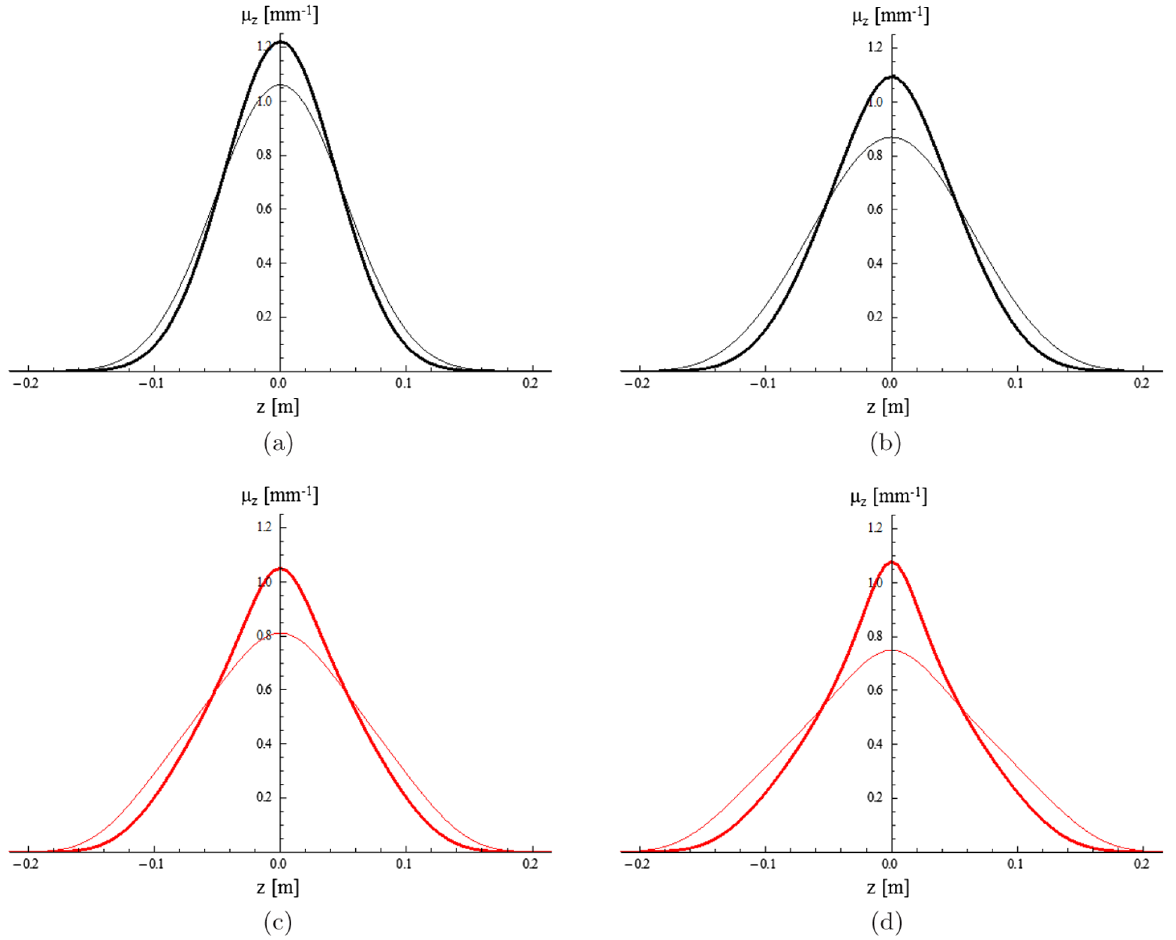
FIG. 4. Line PU density μ z ð z Þ ½ mm − 1 (cid:4) as a function of the longitudinal position z [m] inside the detector. These snapshots are taken at the beginning (thin lines) and in the end (thick lines) of the β (cid:1) leveling process, for different bunch profiles and r.m.s. bunch length σ z . ¼ 135 , which represents the total number of interactions per bunch crossing at the leveled All these distributions are normalized to μ tot luminosity of 5 × 10 34 cm − 2 s − 1 (see Table I). (a) Gaussian bunch profile with σ z ¼ 7 . 5 cm, (b) Gaussian bunch profile with σ ¼ 10 cm, (c) Pseudo-rectangular bunch profile with σ ¼ 10 cm, and (d) Pseudo-rectangular bunch profile with σ z z